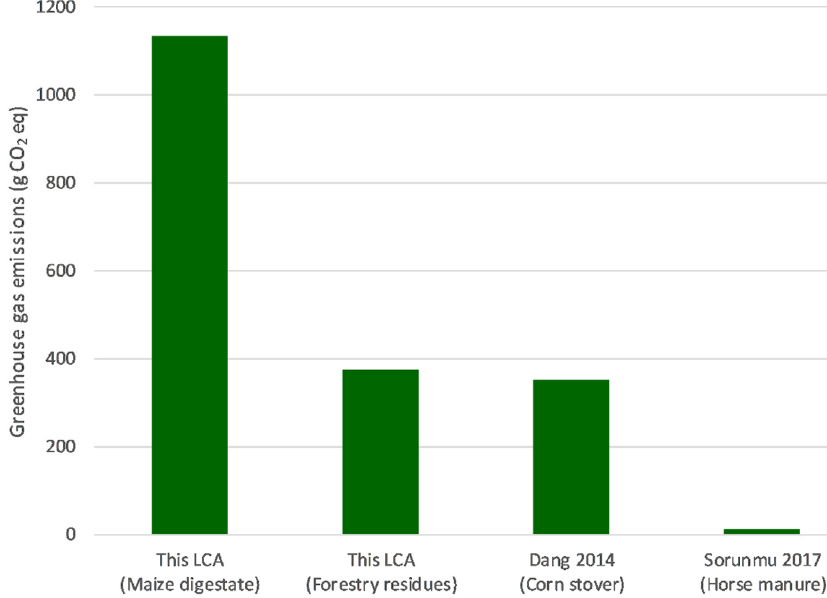
Figure 4. Greenhouse gas emission converted to g CO 2 equivalents per 1 tonne pyrolysis oil. Studies with a negative greenhouse gas (GHG) emission were excluded.